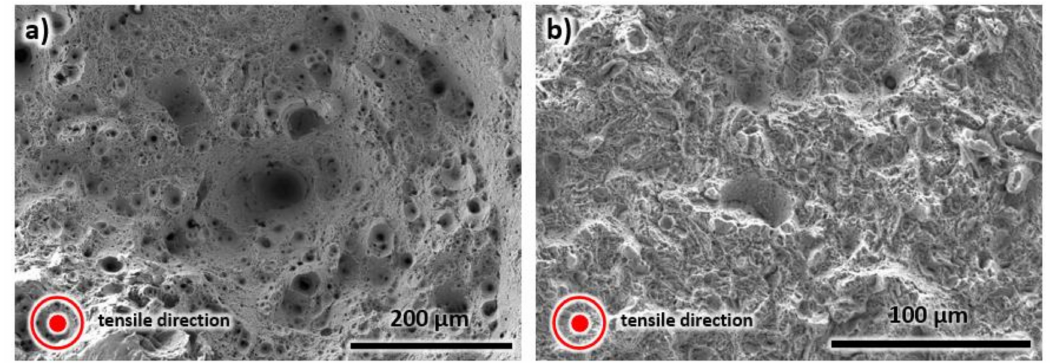
Figure 12. The SEM images of the fractured surface of ( a ) as-printed, and ( b ) heat-treated